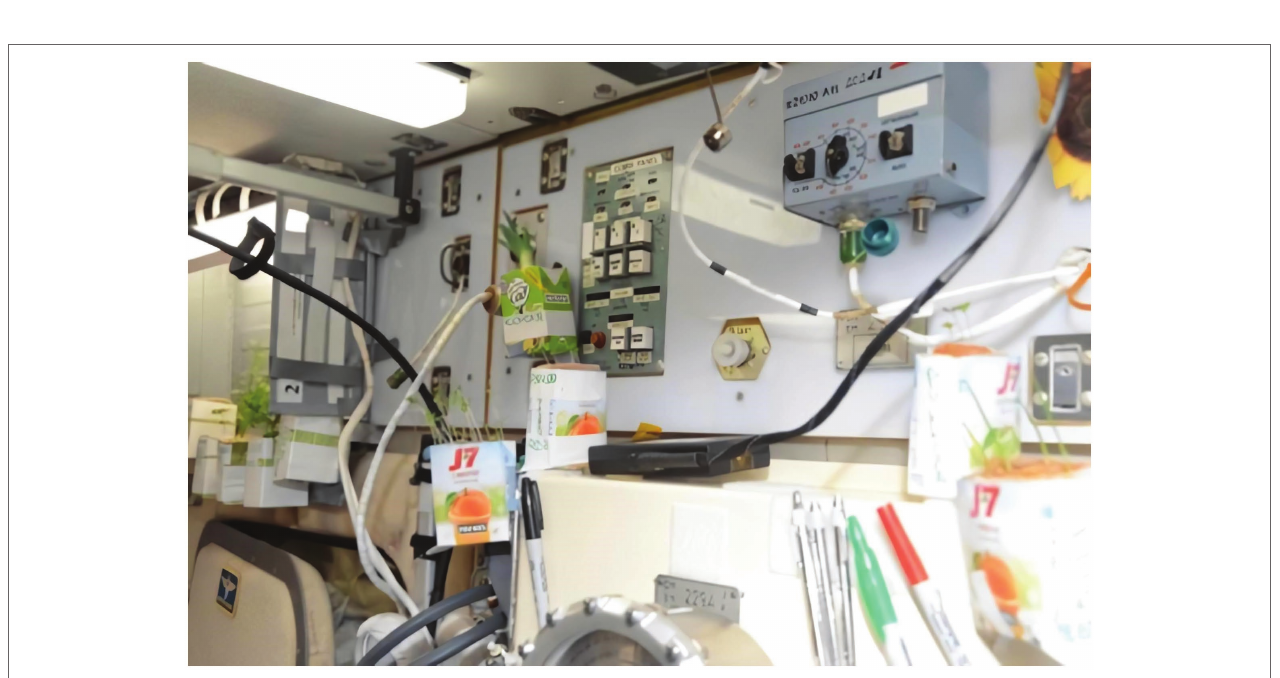
FIGURE 4 | Improvised “houseplants” on board the ISS, grown by the cosmonauts for additional psychological support.